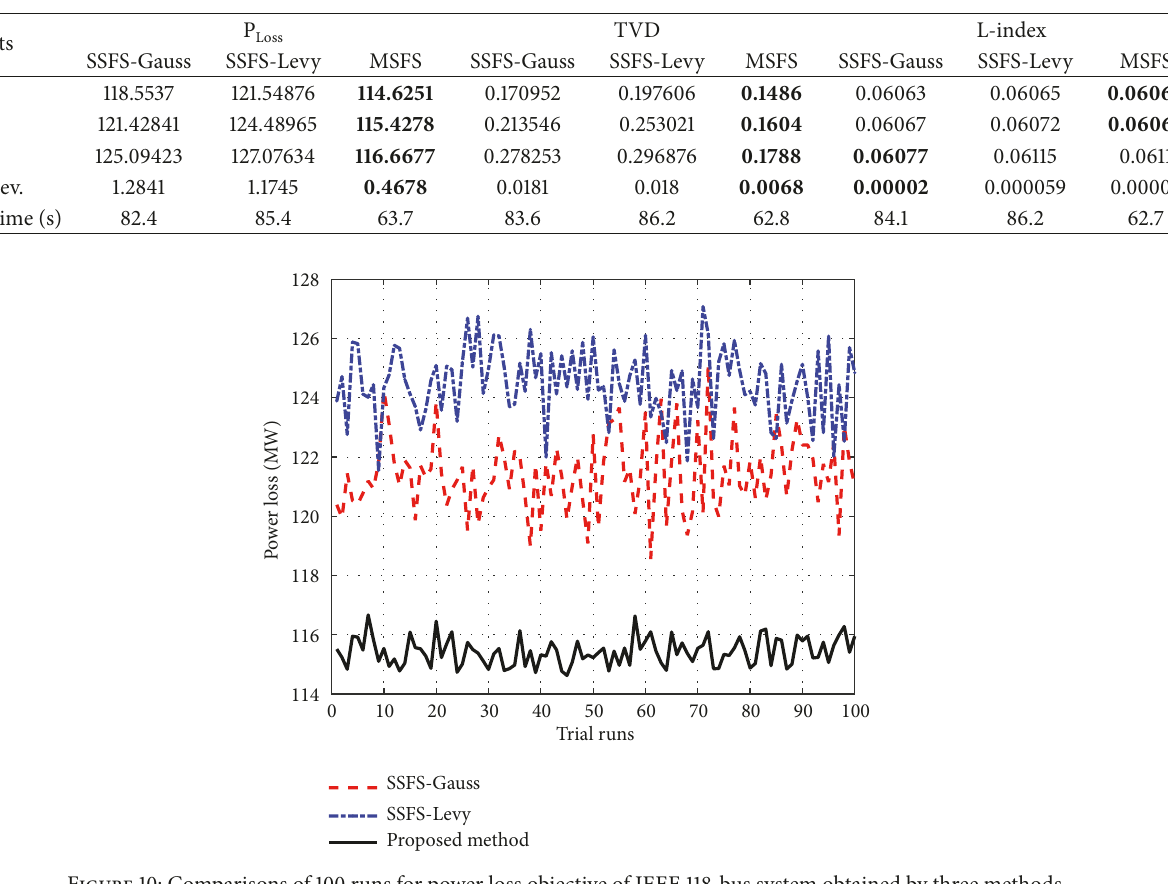
Figure 10: Comparisons of 100 runs for power loss objective of IEEE 118-bus system obtained by three